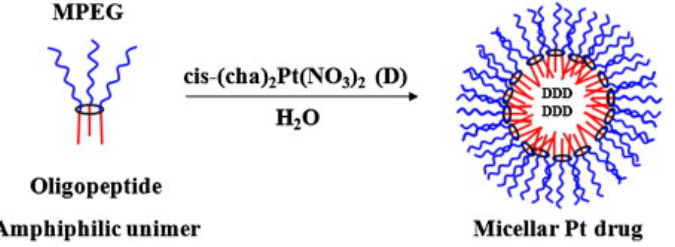
Figure 12. Conceptual diagram for the encapsulation of docetaxel in a cyclotriphosphazene amphiphilic micelle [NP(MPEG750)(GlyPheLeu) permission from